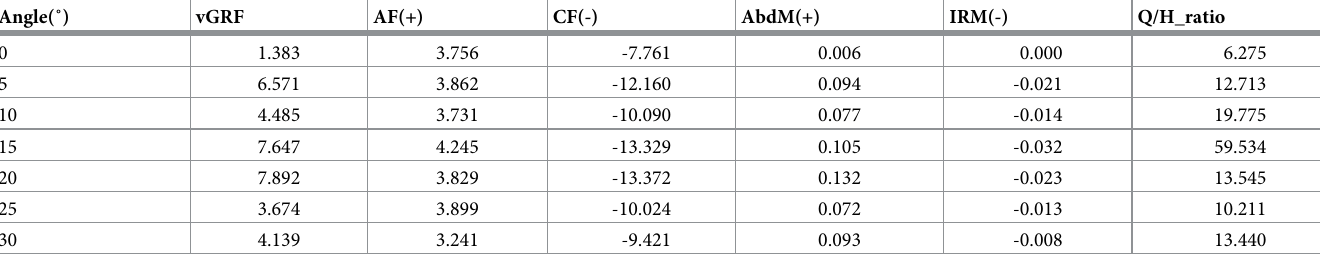
Table 5. Vertical GRF, knee JRF and JRM and Q/H force ratio at peak vGRF time instance for multiple lumbar flexion angles.